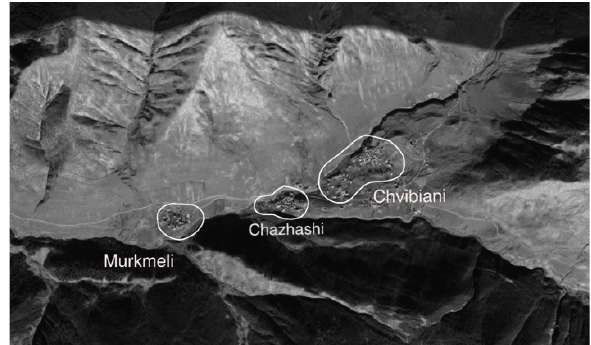
Figure 1. Ushguli`s Settlements strategic position, Ci-ESG, 2019.